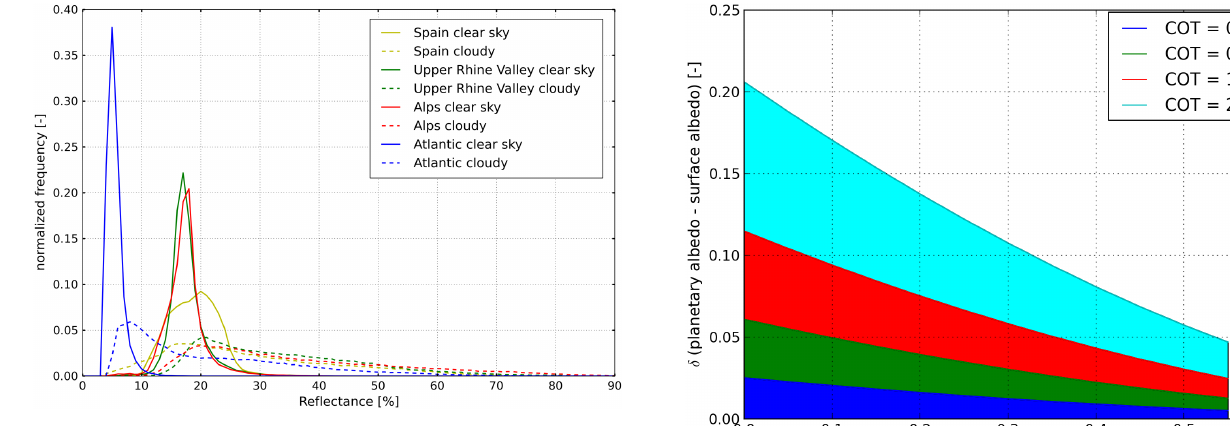
Fig. 3. Normalized frequency distribution of cloudy and clear-sky Fig.3. NormalizedfrequencydistributionofcloudyandclearskyHRVreflectancesoverSpain(yellow),Upper HRV reflectances over Spain (yellow), Upper Rhine Valley (green), RhineValley(green),theAlps(red)andAtlantic(blue)observedbyMSGSEVIRI.Separationbetweencloudy the Alps (red) and Atlantic (blue) observed by MSG SEVIRI. Sep- (dotted line) and clear sky (solid line) reflectances is based on EUMETSAT cloud mask. EUMETSAT cloud aration between cloudy (dotted line) and clear-sky (solid line) re- mask is upsampled to HRV resolution. flectances is based on EUMETSAT cloud mask. EUMETSAT cloud mask is upsampled to HRV resolution.